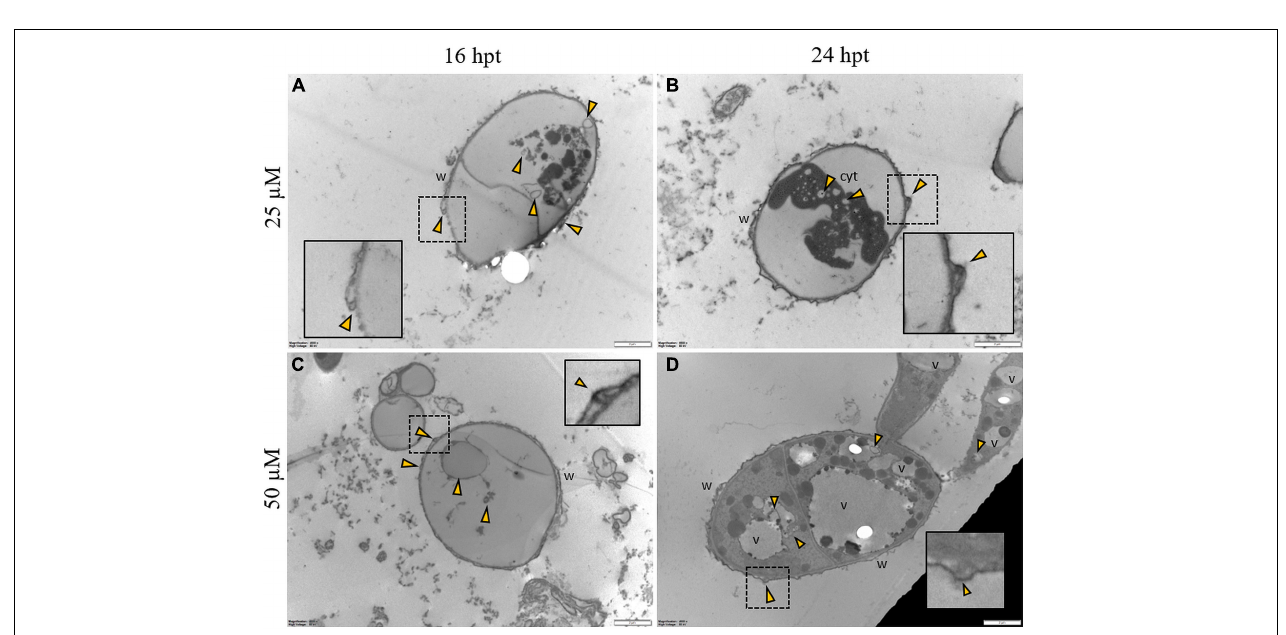
FIGURE 8 | Representative TEM micrographs of Pyricularia oryzae untreated conidia and hyphae. (A) Conidia are featured with regular submicroscopic structure and well-identifiable organelles. The numerous mitochondria with membranous cristae indicate intense cell metabolism. (B-D) Hyphae, at 24 (B) , 36 (C) and 48 (D) hours after the beginning of conidial germination, show electron dense cytoplasm and well defined vacuoles. Er: endoplasmic reticulum; l: lipid drop; m: mitochondrion; n: nucleus; v: vacuole. In A and B, magnification bars correspond to 1 µ m; in C and D magnification bars correspond, respectively, to 2 µ m and 500 nm.